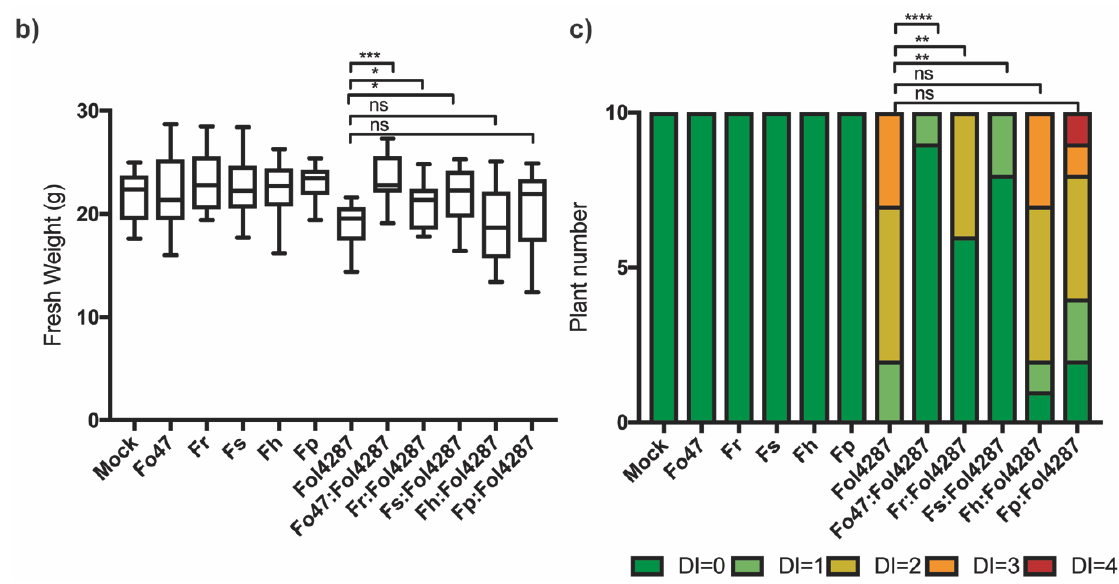
Figure 2. Fo47, Fusarium redolens (Fr), Fusarium solani (Fs), Fusarium hostae (Fh), and Fusarium proliferatum (Fp) can reduce Fusarium wilt disease symptoms in tomato. ( a ) Representative tomato plants three weeks after inoculation; ( b ) fresh weight and ( c ) disease index (DI) of tomato plants three weeks after inoculation. DI = 0 no brown vessels; DI = 1 brown vessel(s) only at basal level; DI = 2 one or two brown vessels at cotyledon level; DI = 3 three brown vessels at cotyledon level, DI = 4 all vessels are brown, DI = 5 the plant is dead. Data were analysed by a nonparametric Mann–Whitney U-test ( ns P > 0.05; * p < 0.05, ** p < 0.01; *** p < 0.001); ( d ) Ten tomato stems pieces from crown level